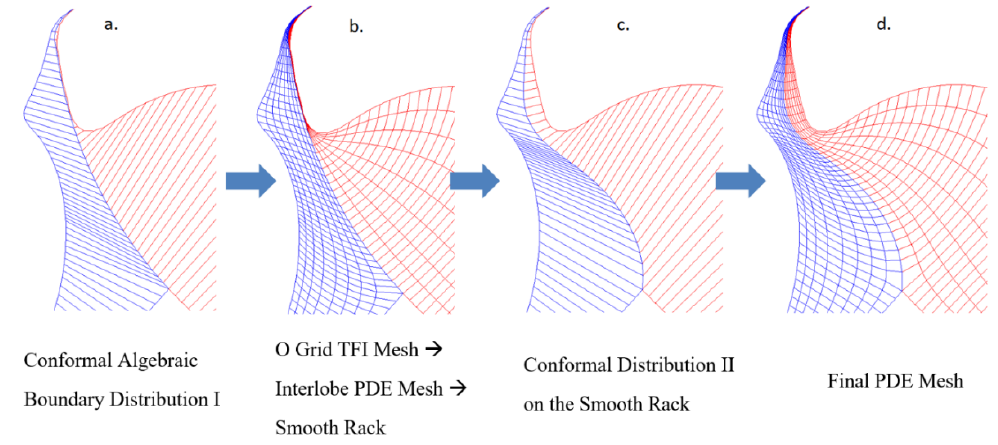
Figure 5. Four-step procedure for improving time transition of the rack curve.